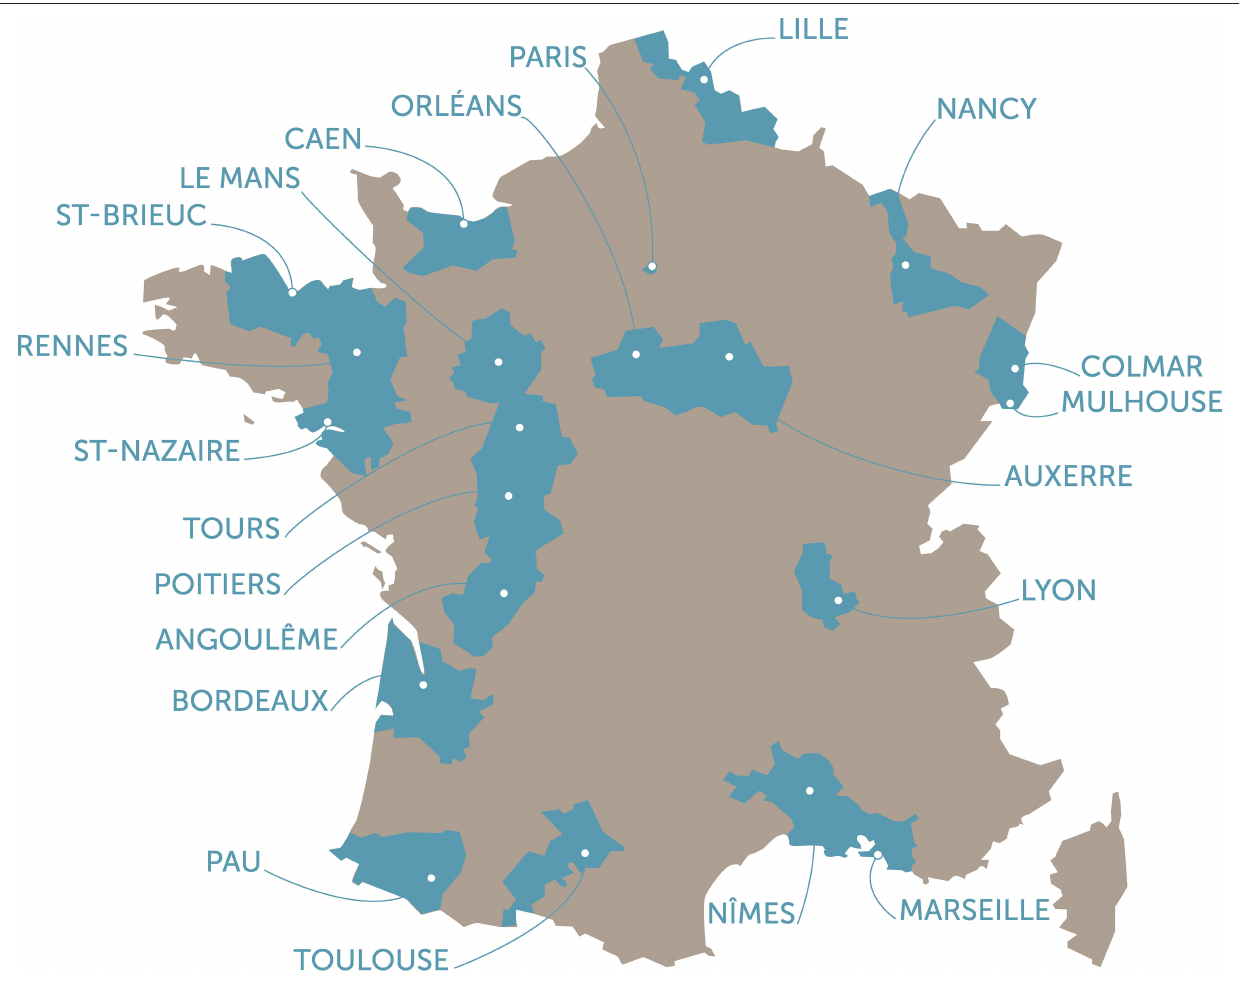
FIGURE 1 | Location of the 24 participating Health Prevention Centers (HPC, Centre d’examens de santé) throughout the 21 cities metropolitan France.